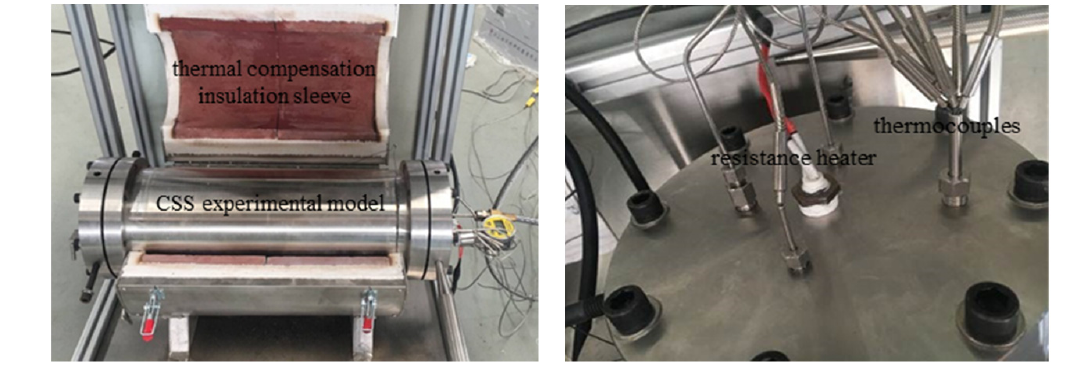
( b ) Physical picture of experimental setup Figure 2. The experimental equipment of E-CSS: ( a ) schematic figure; ( b ) Physical picture.